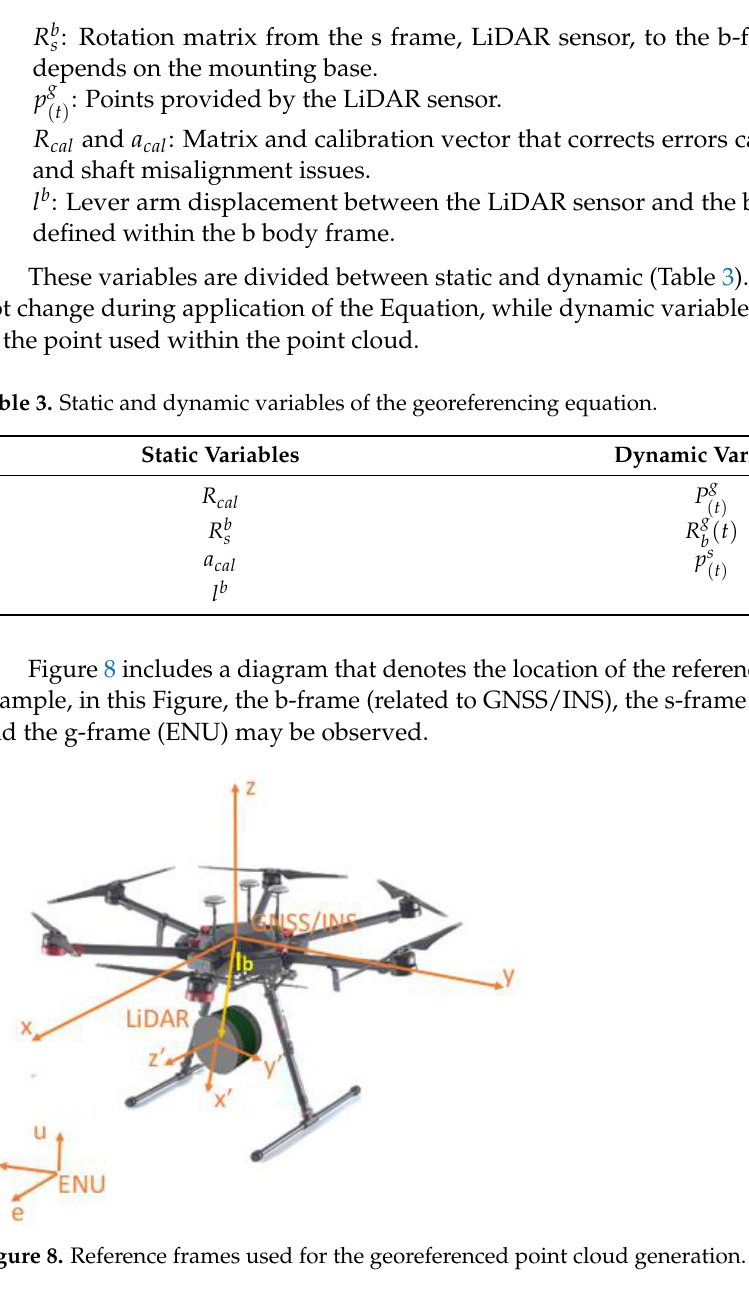
Figure 9. Non-calibrated point cloud from the LiDAR reference system (x, y, z).